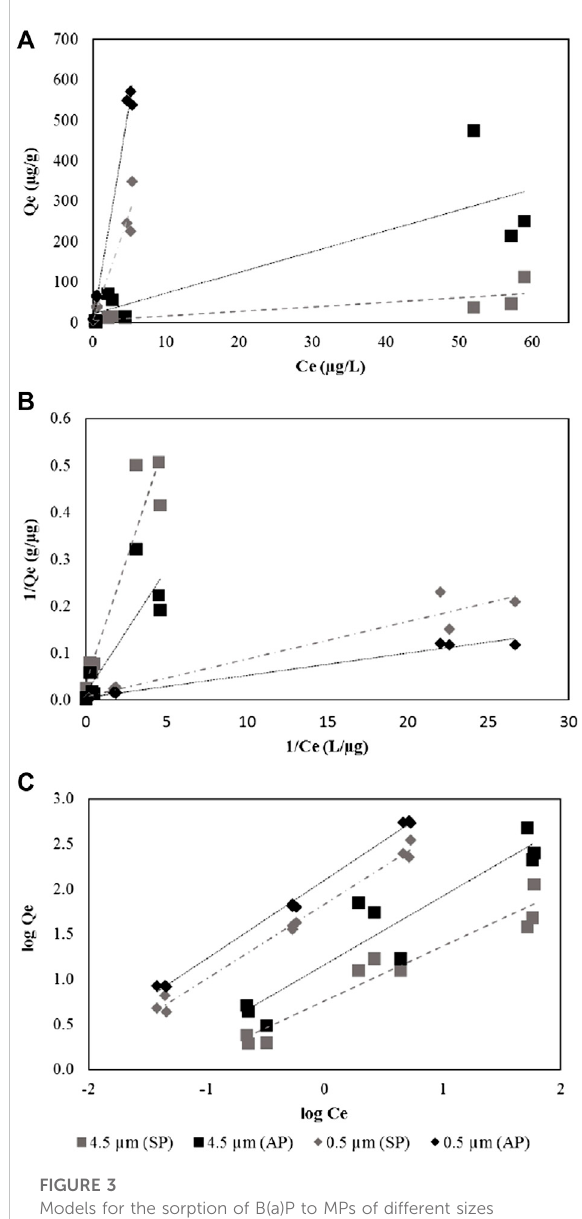
FIGURE 3 Models for the sorption of B(a)P to MPs of different sizes depending on the analyzed fraction (AP and SP). (A) Linear model, (B) Langmuir model, and (C) Freundlich